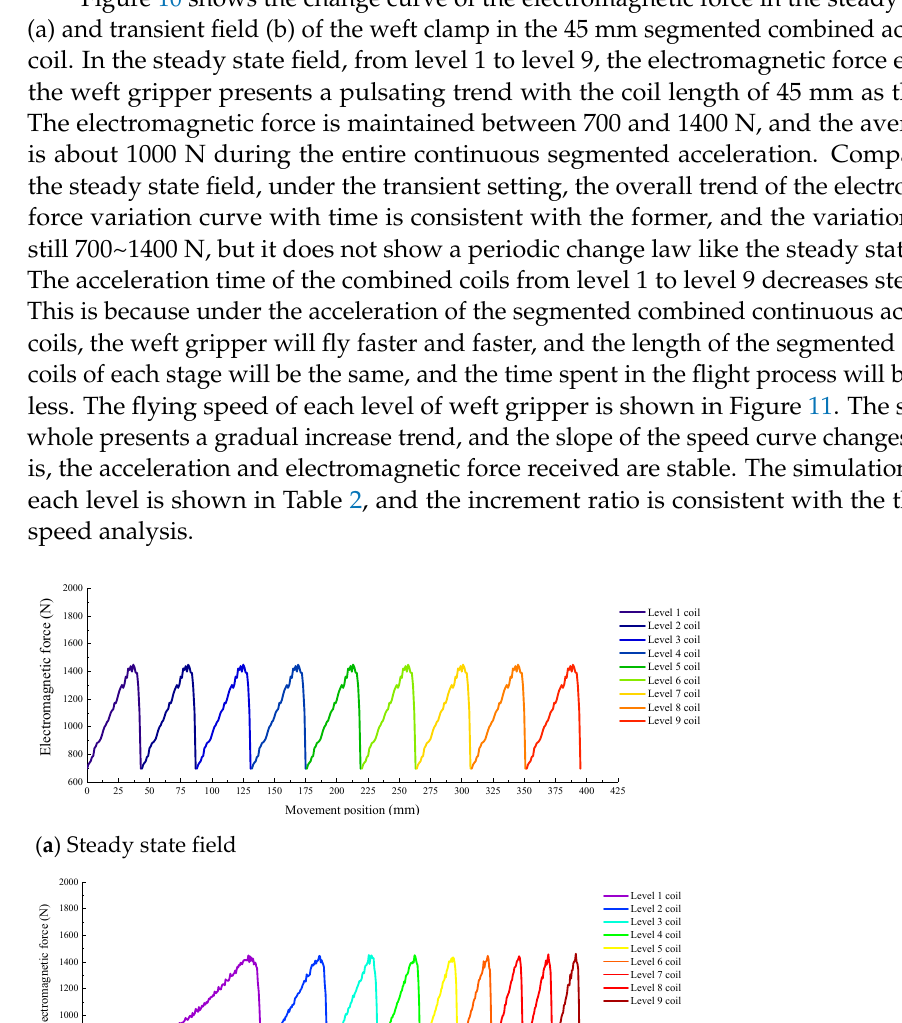
Figure 9. Electromagnetic field simulation of segmented combined 45 mm coil.